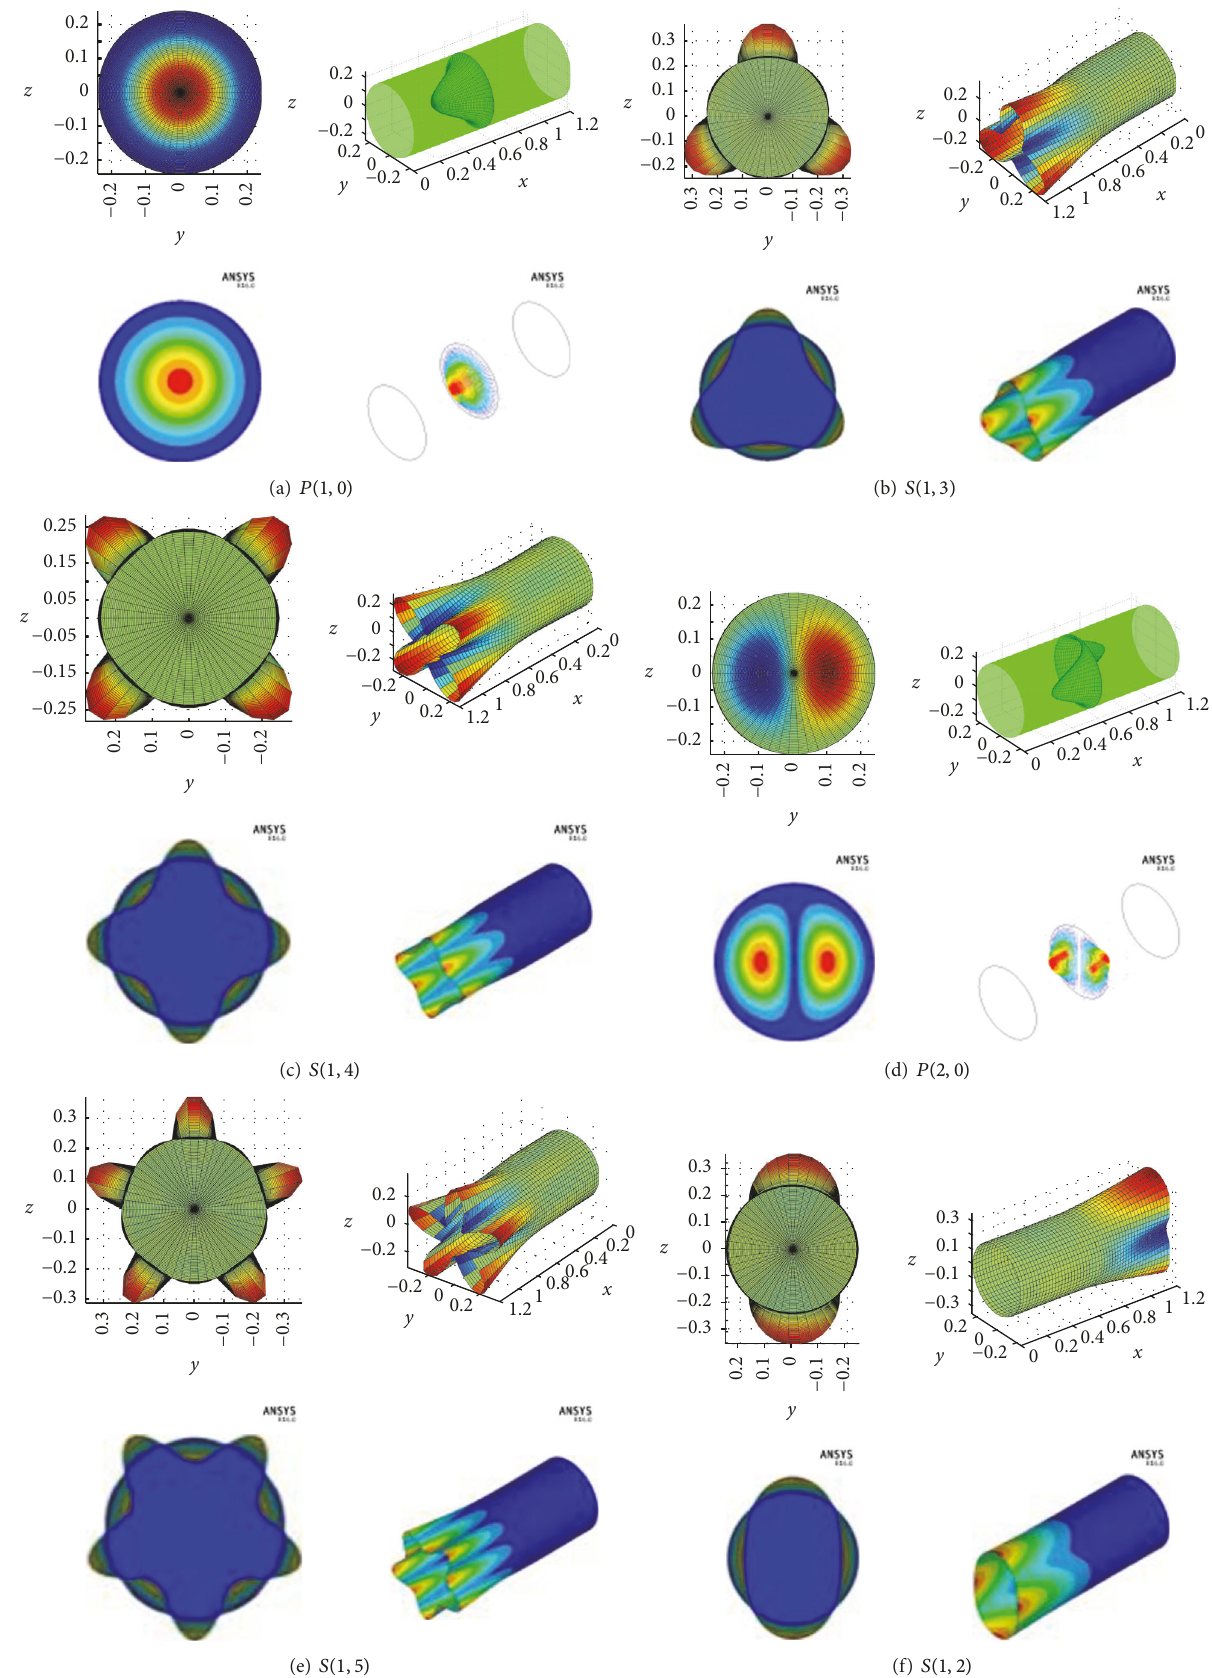
Figure 6: The modes of coupled structures with